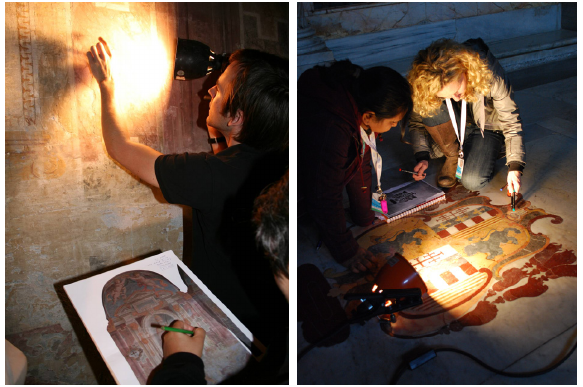
Figure 2 and 3. Left, team evaluating wall frescos at the ICCROM-GCI ARIS course, 2007 Right, team evaluating stone deterioration at the ICCROM Built Heritage Course, 2012